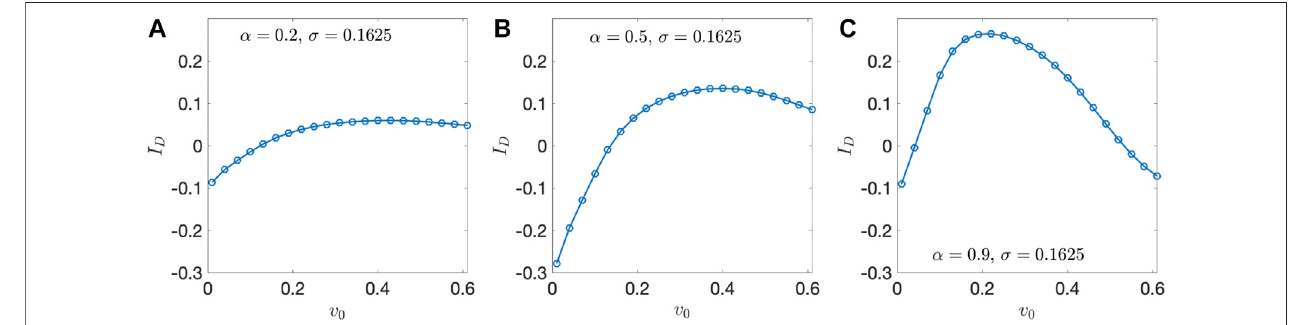
FIGURE 7 | Depletion index I D dependence on v 0 for selected values of α > 0 and σ (cid:1) 0.1625. (A) α (cid:1) 0.2. (B) α (cid:1) 0.5. (C) α (cid:1)